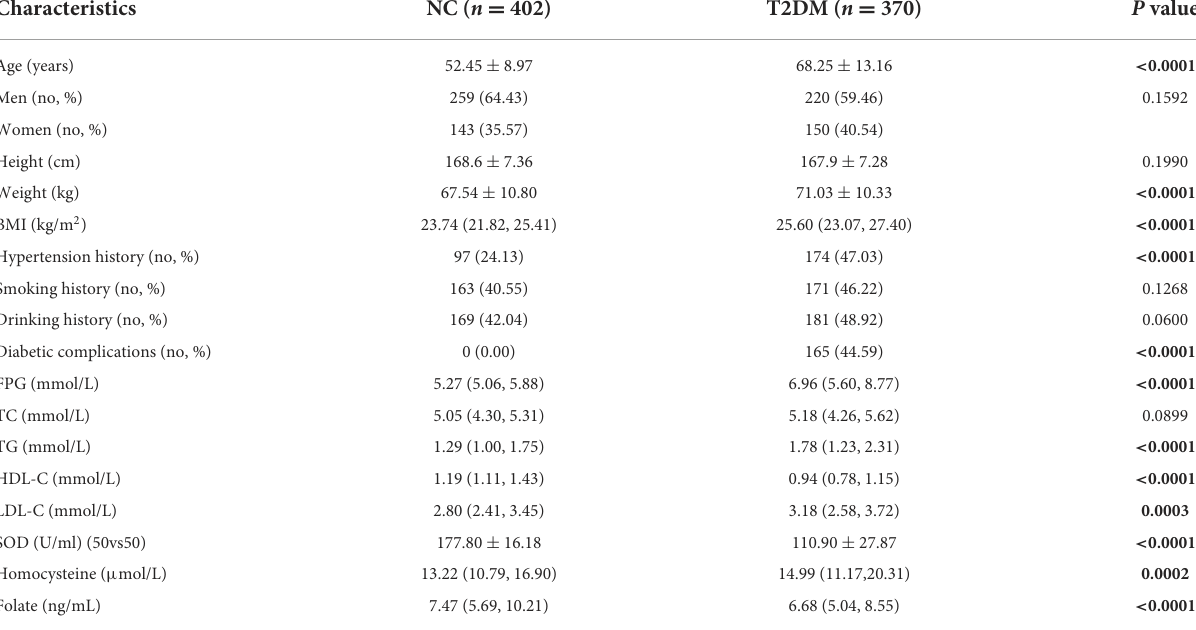
TABLE 1 Characteristics in controls and patients with type 2 diabetes. Characteristics